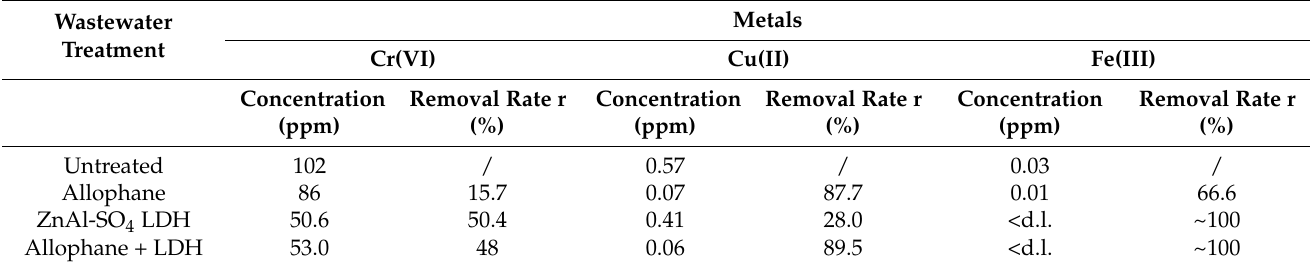
Table 1. Equilibrium concentration value and removal rate of ionic species in the presence of a constant mass (5 g/L) of different sorbents. The data are averaged on triplicate